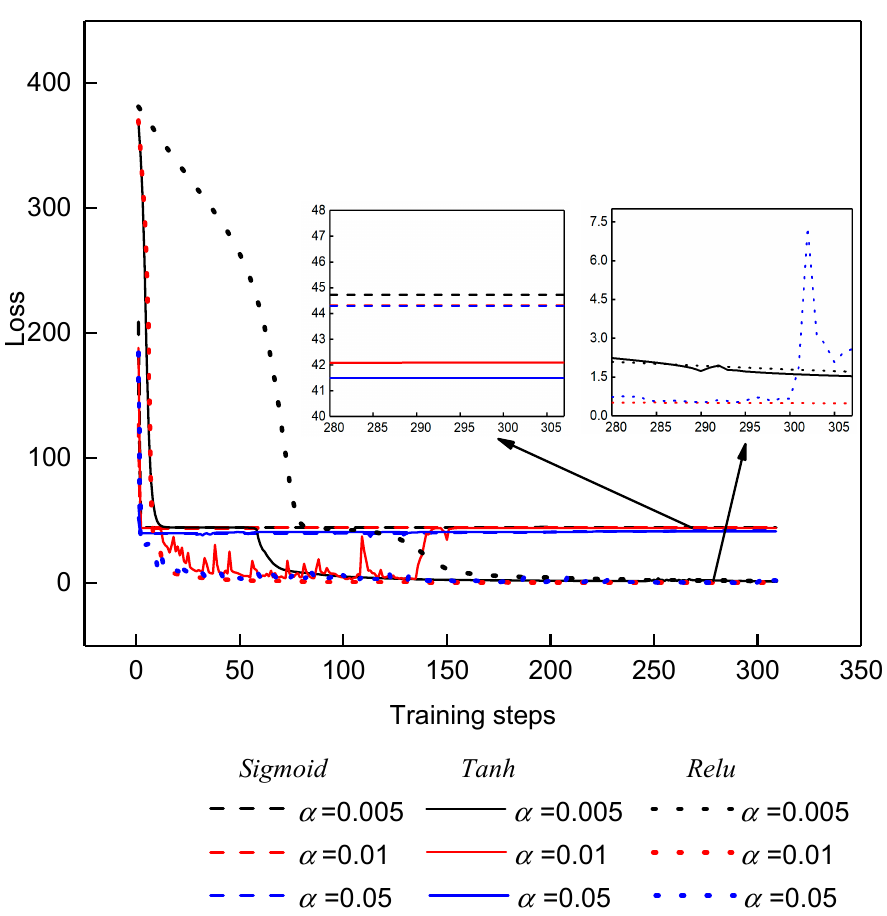
Figure 14. Variation of loss with training step number under different activation functions and learning rates.